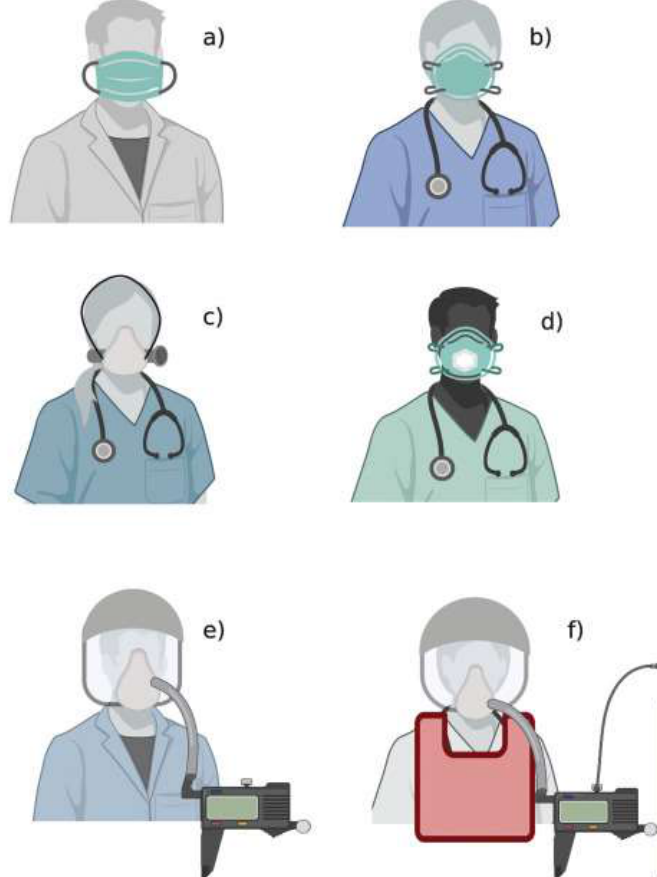
Figure 3. Masks and respirators based on EU standards: ( a ) medical mask; ( b ) filtering facepiece respirator; ( c ) elastomeric respirator; ( d ) filtering facepiece respirator with expiratory valve; ( e )